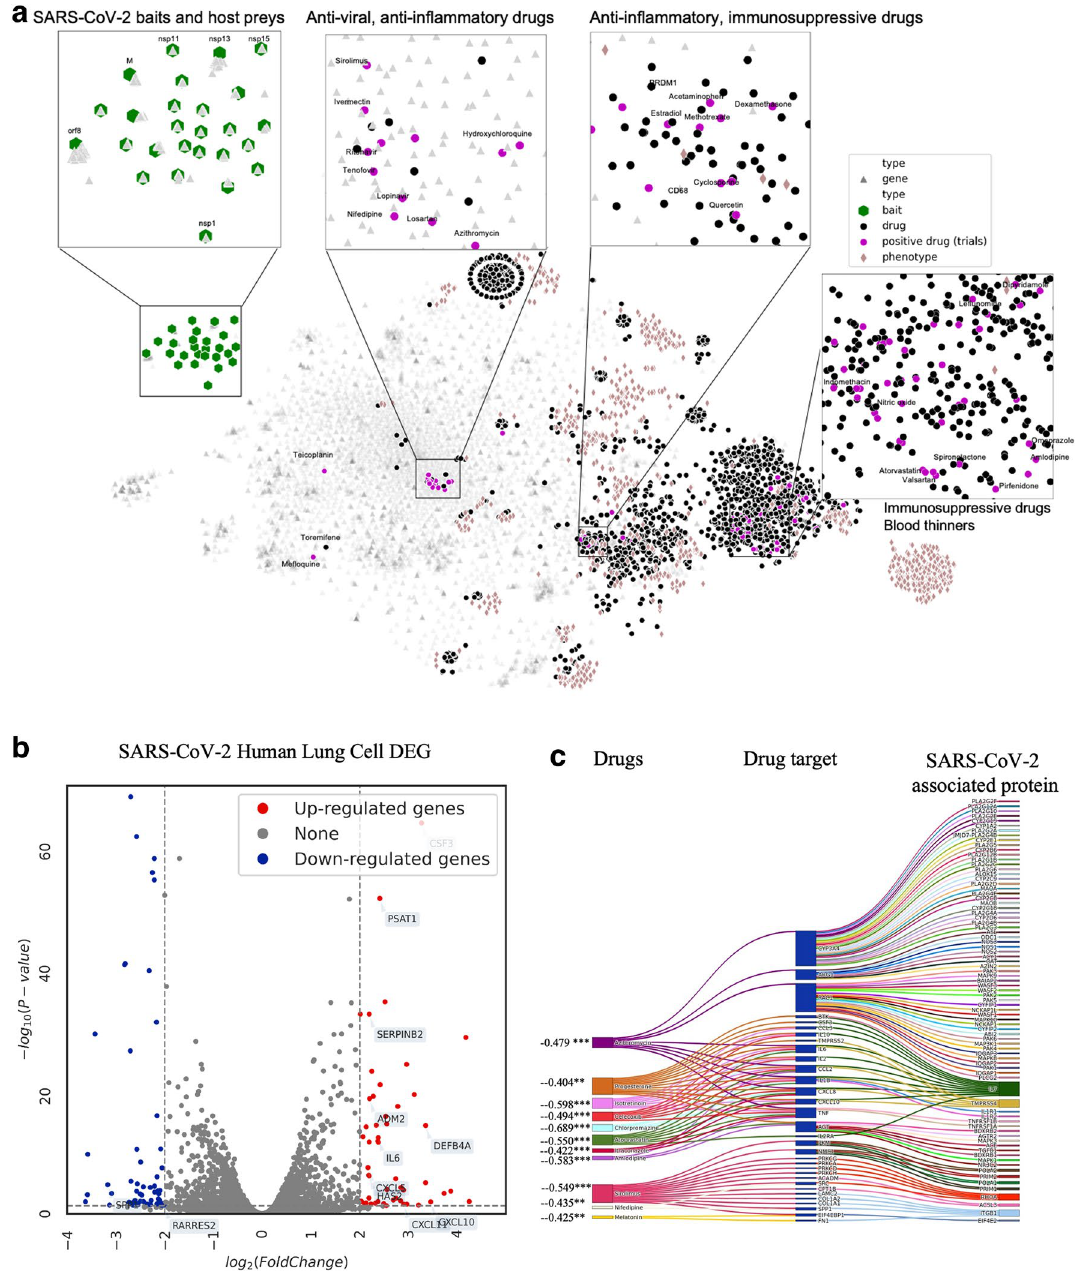
Figure 2. ( a ) COVID-19 knowledge graph t -SNE plot. Two nodes that have similar embedding are closely located in the t -SNE plot. We highlighted drugs undergoing clinical trials (as of July 23, 2020) to glimpse the promising repurposable drugs around the trial drugs. SARS-Cov-2 baits were the upper-left green hexagons. Genes, the gray triangles, were in the middle between baits and drugs. Drugs, the black rounds, were mixed with genes. Drugs undergoing clinical trials, the purple rounds, were closely located together. Phenotypes, the light brown diamonds, were closely located relevant genes and drugs. An interactive plot for a closer look is available in Fig. S2b–e we validated the drug ranking using four different external validation sources including. ( b ) Differentially expressed genes in SARS-CoV-2-infected human lung cells (GSE153970). ( c ) GSEA score between the infected human lung cell transcriptome and drug-induced transcriptome. ( d ) In vitro efficacy (e.g. % inhibition in viral entry and cytopathic effect assays 8 ), and ( e ) treatment effects in EHRs. Figure ( c ) was created by Plotly 22 (https:// plotly.